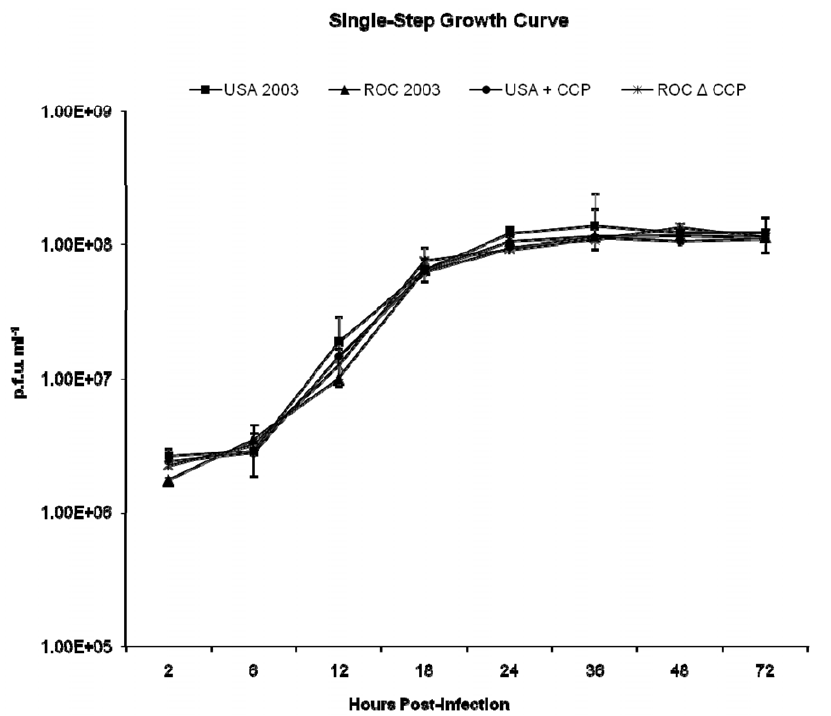
Figure 4. Monkeypox growth curve. Single step growth curves of the parental (ROC 2003, USA 2003) and recombinant (ROC D CCP, USA + CCP) monkeypox virus strains. No statistically significant differences were identified between the strains (p . 0.05).